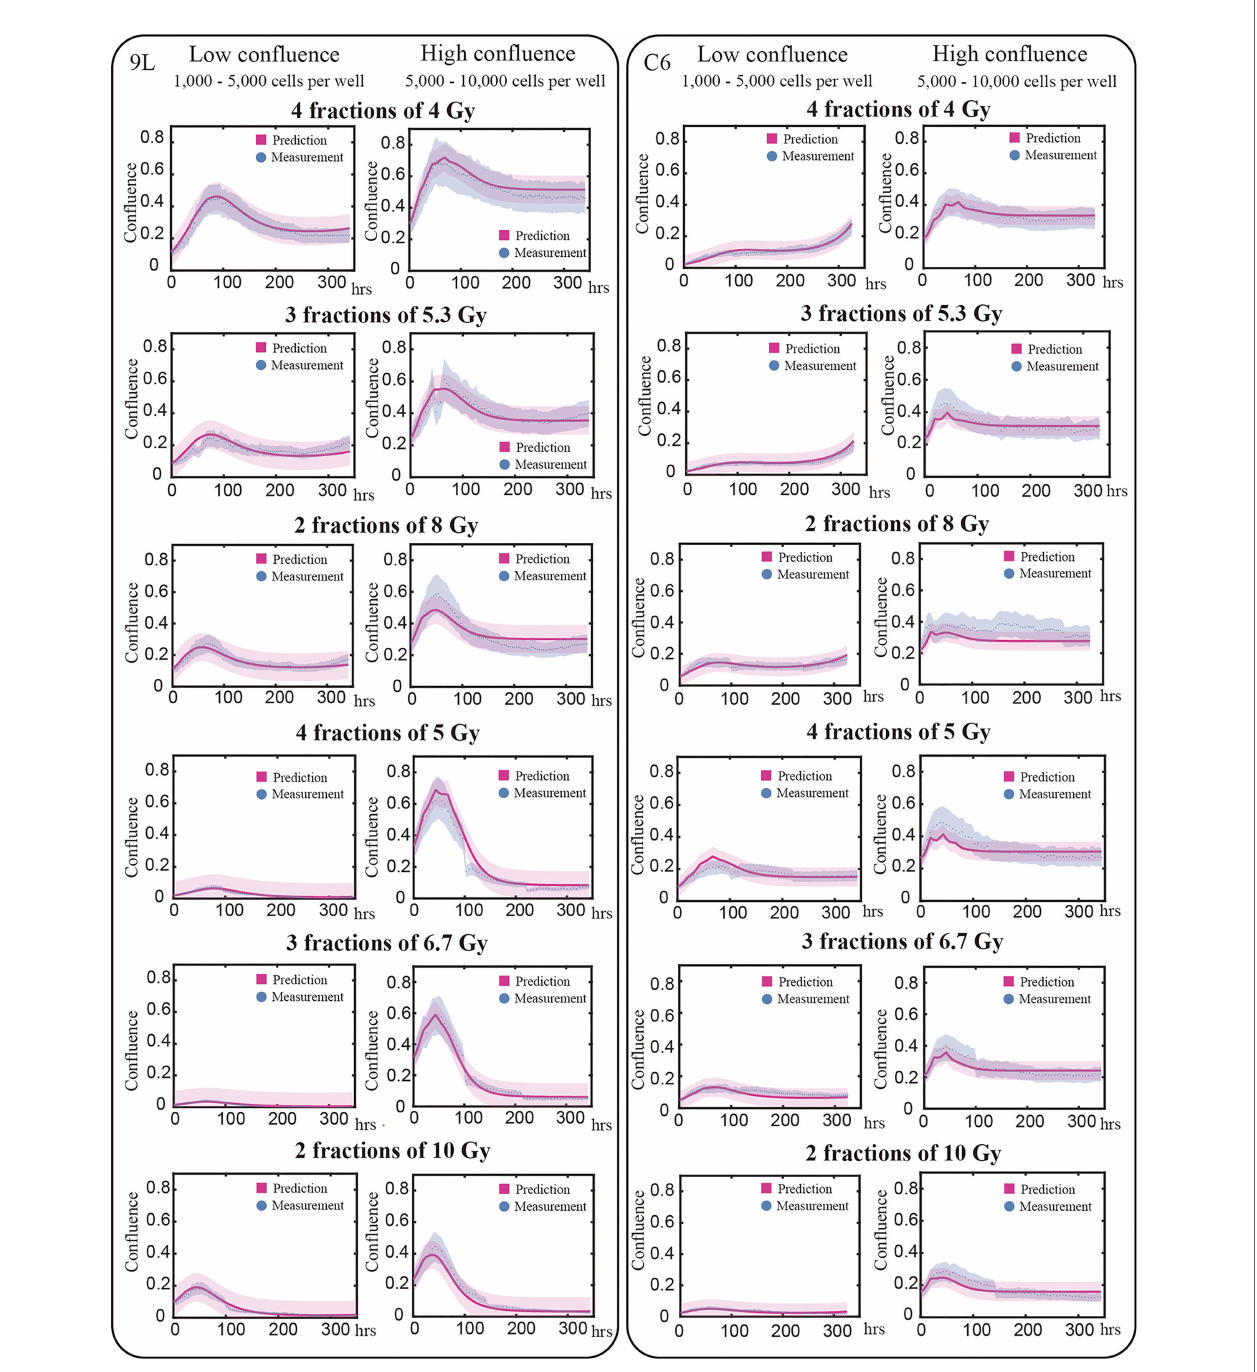
FIGURE 6 | Model validation. The prediction interval (labeled by red) and measured microscopy data (labeled blue dots) are plot for representative examples of each initial and treatment condition. Previously we determined our average segmentation error was 21% using the Sørensen – Dice coef fi cient (10). This segmentation error is indicated by the blue intervals. Each row in this fi gure shows different treatment schedules labeled on the left; for example, the fi rst row shows cells treated with four fractions of 4 Gy. Each column stands for the initial con fl uence for a speci fi c cell line; for example, the fi rst column represents low initial seeding density for 9L cell line. Predictions are made globally for each of the cell lines; that is, predictions for the 9L cells with an initial low con fl uence receiving four fractions of 4 Gy are made using the same set of parameters as the 9L cells with an initial high con fl uence receiving two fractions of 10 Gy. Given the initial con fl uence and treatment schedule as the two inputs, our model makes accurate predictions across a wide range of initial conditions. However, the model is not perfect as the prediction typically undershoots the fi rst peak while overshooting the tail for C6 cell line; an important point we return to in the Discussion